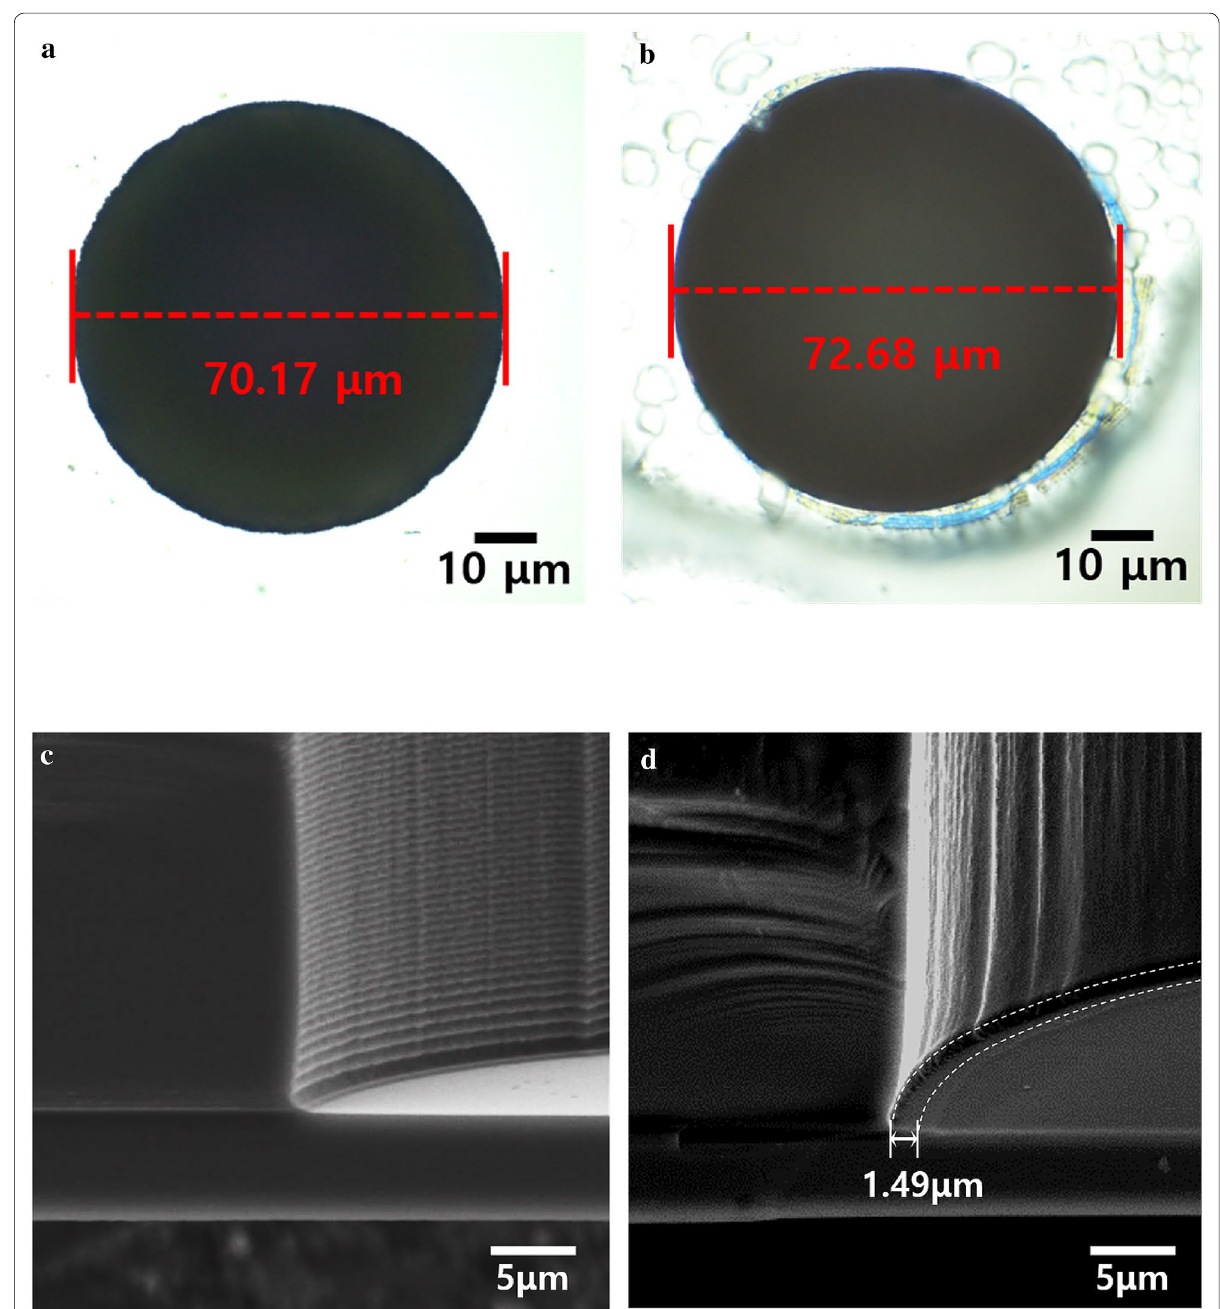
Fig. 7 Optical top view images of the opening trenches ( a ) before and ( b ) after the scallop smoothing RIE. Cross‑sectional SEM images at the bottom of the trenches ( c ) before and ( d ) after scallop smoothing RIE for 30